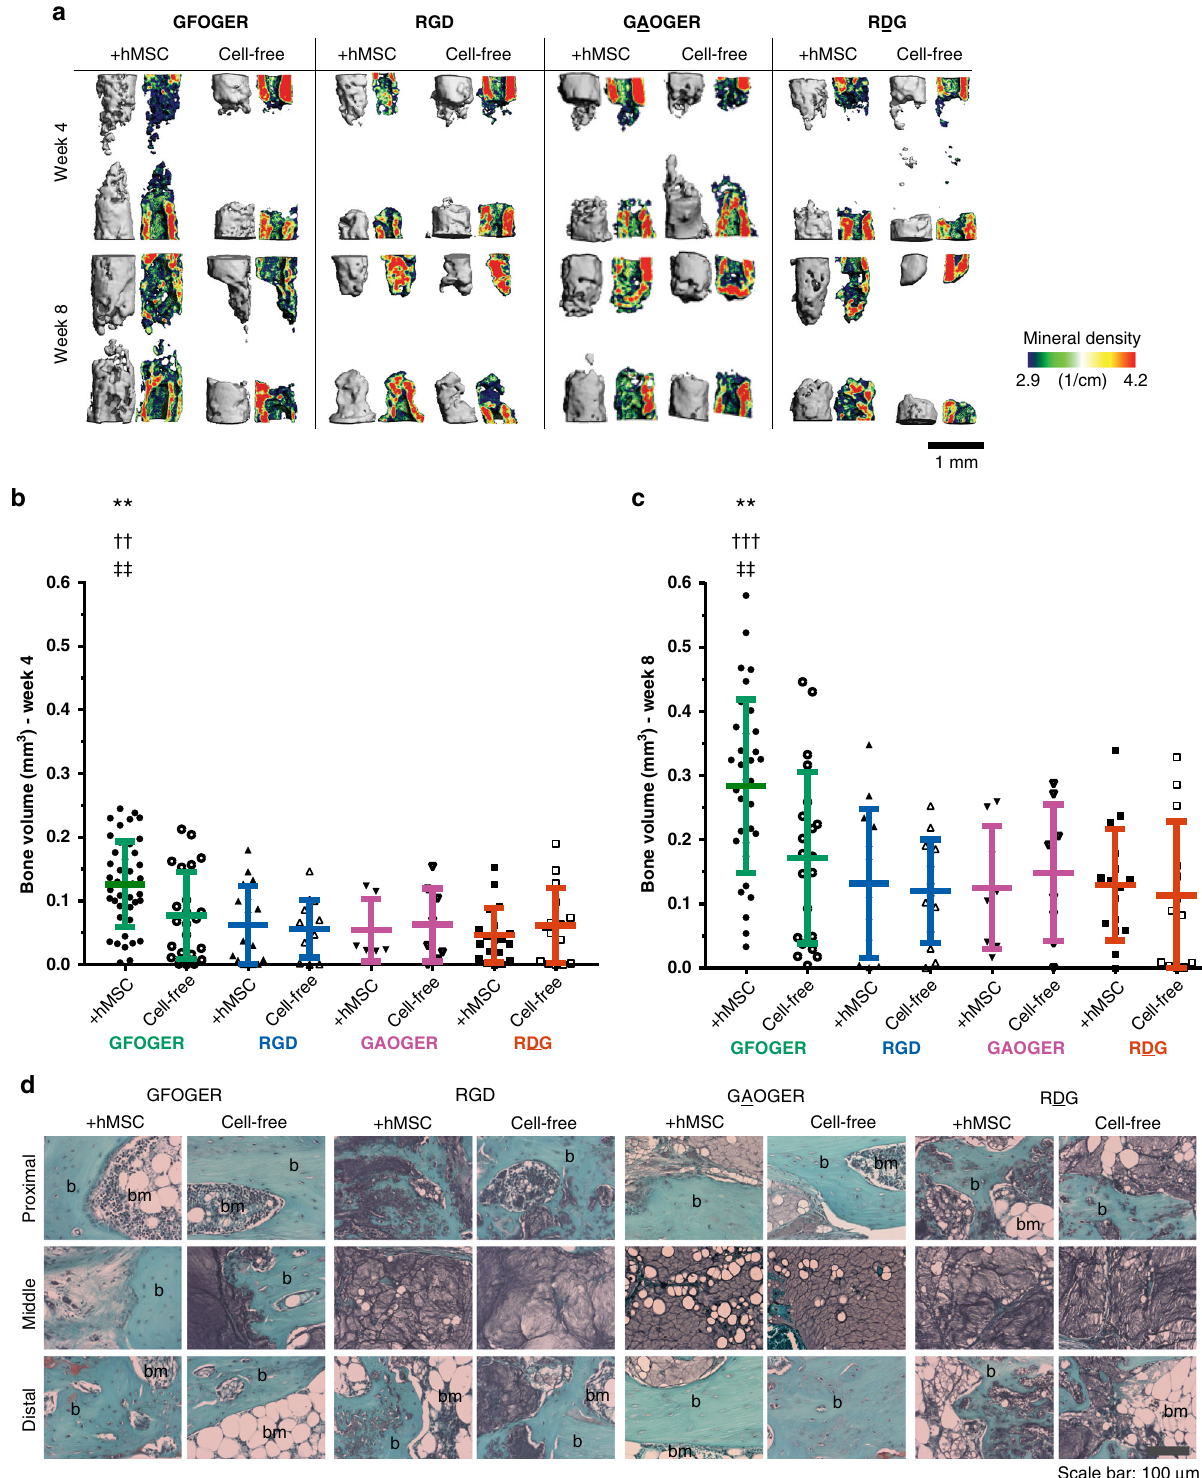
Fig. 4 GFOGER-functionalized hydrogels enhance bone repair with hMSC transplantation. Peptide-functionalized hydrogels with or without encapsulated hMSCs were implanted into radial segmental defects in NSG mice. a Bone formation was monitored with live animal µ CT. Representative 3-D reconstructions with sagittal mineral density heat maps. Scale bar 1.0 mm. Bone volume was quanti fi ed in the middle 2.0 mm of the original 2.5 mm defect at b week 4 and c week 8. Sample size (mice): GFOGER = 34 ( + hMSC), 22 (cell-free), RGD = 13 ( + hMSC), 13 (cell-free), GAOGER = 8 ( + hMSC), 8 (cell-free), RDG = 15 ( + hMSC), 13 (cell-free), over fi ve independent experiments; mean ± SE. ANOVA ( p < 0.0001) was used to detect statistical differences followed by Sidak ’ s multiple comparisons test, ** p < 0.009 GFOGER vs. GAOGER; †† p < 0.001, ††† p < 0.0006 GFOGER vs. RGD; ‡‡ p < 0.008, GFOGER + hMSC vs. GFOGER cell-free. d Safranin-O and fast green immunohistochemical staining of defects at weeks 4 and 8 (b: bone, bm: bone marrow). Scale bar 100 µ